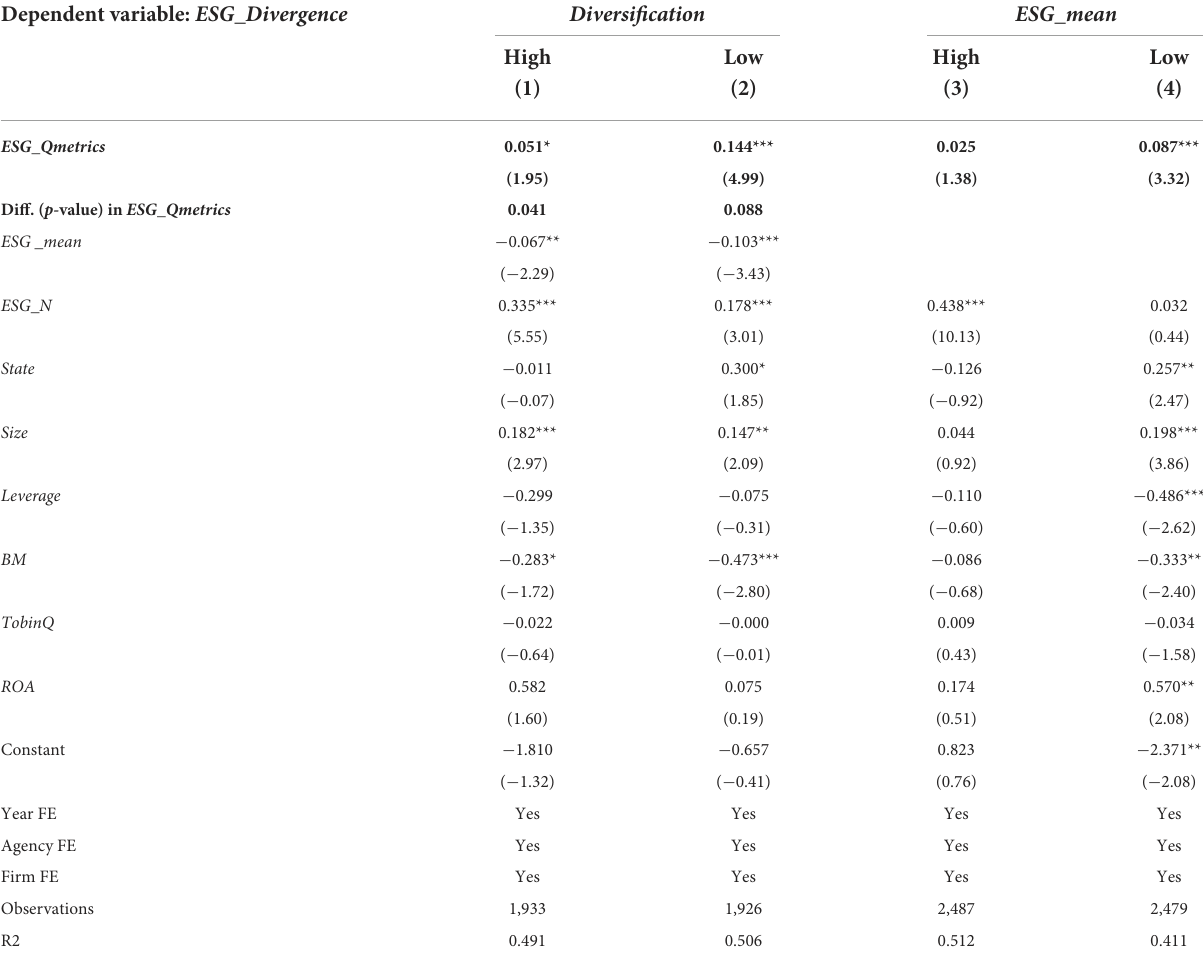
TABLE 7 Heterogeneous effects of ESG quantitative disclosure on ESG ratings divergence: role of diversified operation and ESG performances. Dependent variable: